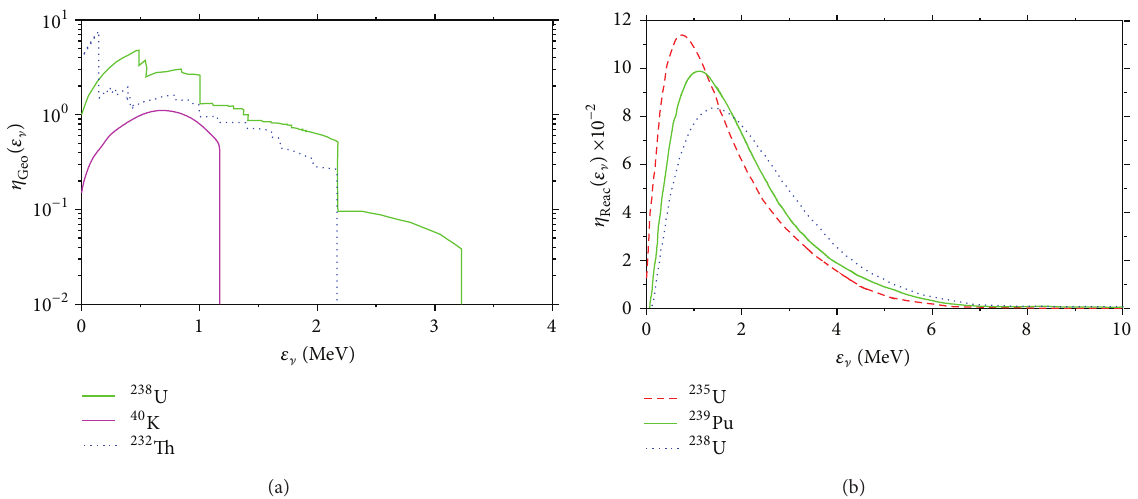
Figure 3: (a) Spectra of the U Series, Th Series, and 40 K geoneutrinos. Neutrinos from 40 K electron capture are also shown in this figure. (b) Normalized reactor neutrino